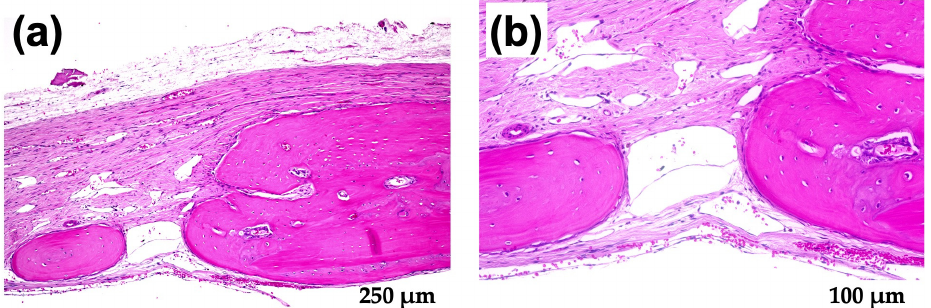
Figure 13. ( a ) Magnified HE-stained image of the dotted square zone “X2” in Figure 11d (4× magni- fication). ( b ) Further magnified HE-stained image of the interspace between the two bones in Figure 13a (10× magnification).